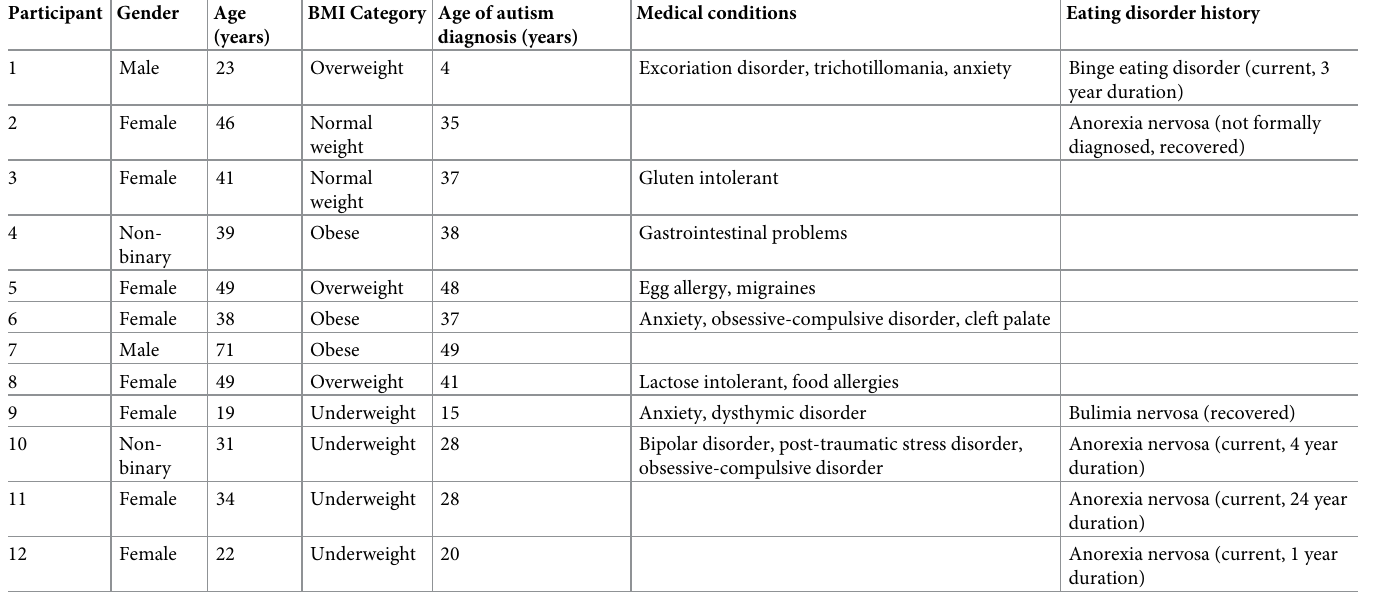
Table 1. Participant demographic